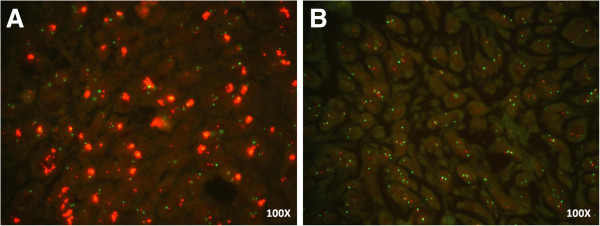
HER2 gene amplification by FISH. (A) Representative image of a positive case for HER2 amplification in ESCC. (B) Representative image of a negative case for HER2 amplification in ESCC.